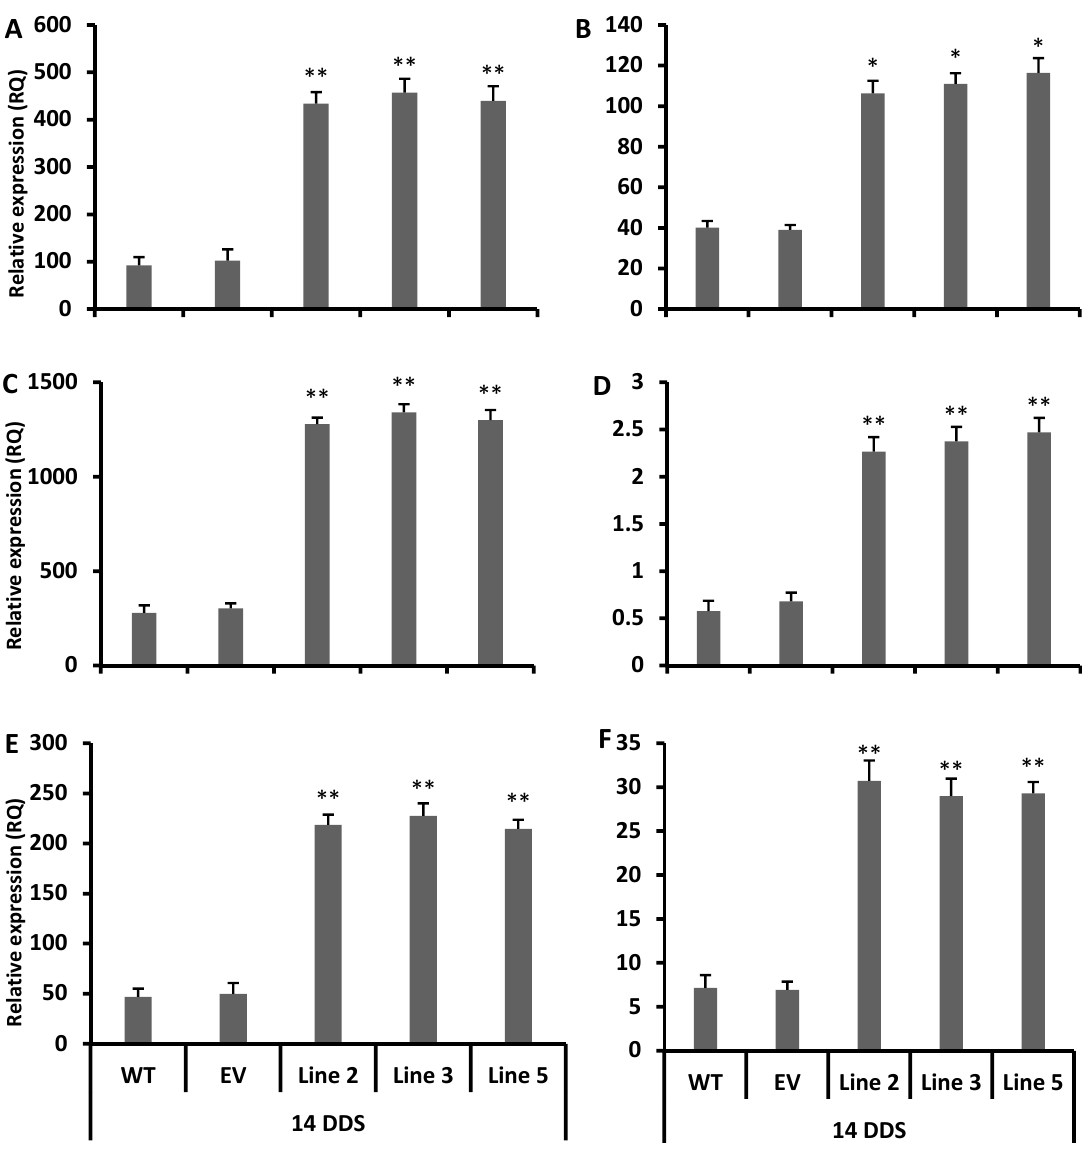
Figure 4. The q-PCR relative expression data of 6 genes under drought stress: ( A ) AT5G13930 TT4, ( B ) AT3G55120 TT5, ( C ) AT3G51240 TT6, ( D ) AT5G08640 FLS, ( E ) AT3G13610 F6 ′ H1, and ( F ) AT4G22880 TT18. Gene IDs were taken from Arabidopsis genome website TAIR (https://www.arabidopsis.org/). FLS: flavonol synthase. 14DDS: after 14 days of drought stress. WT: wild type. EV: empty vector. A Students t -test was used to compare the CYT-OX and WT plants at * p < 0.05 and ** p < 0.01. Each value is